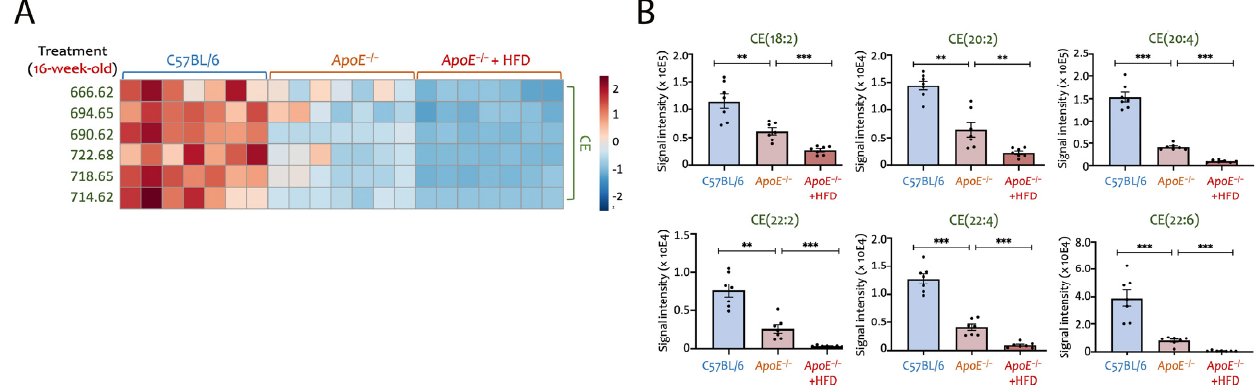
Figure A4. High-fat diet-fed apoE − / − mice showed decreased cholesteryl ester levels. Data was